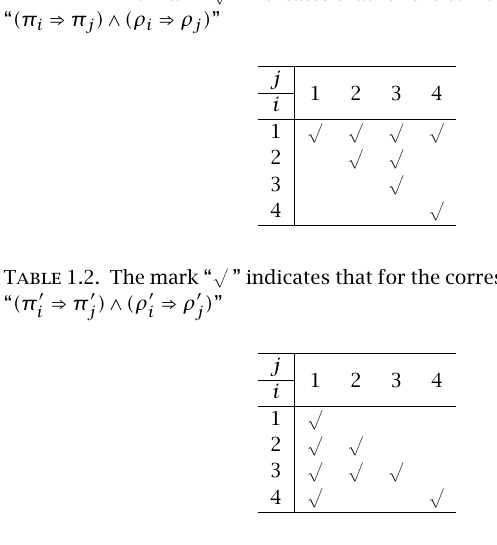
√ Table 1.1 . The mark “ ” indicates that for the corresponding case we have: